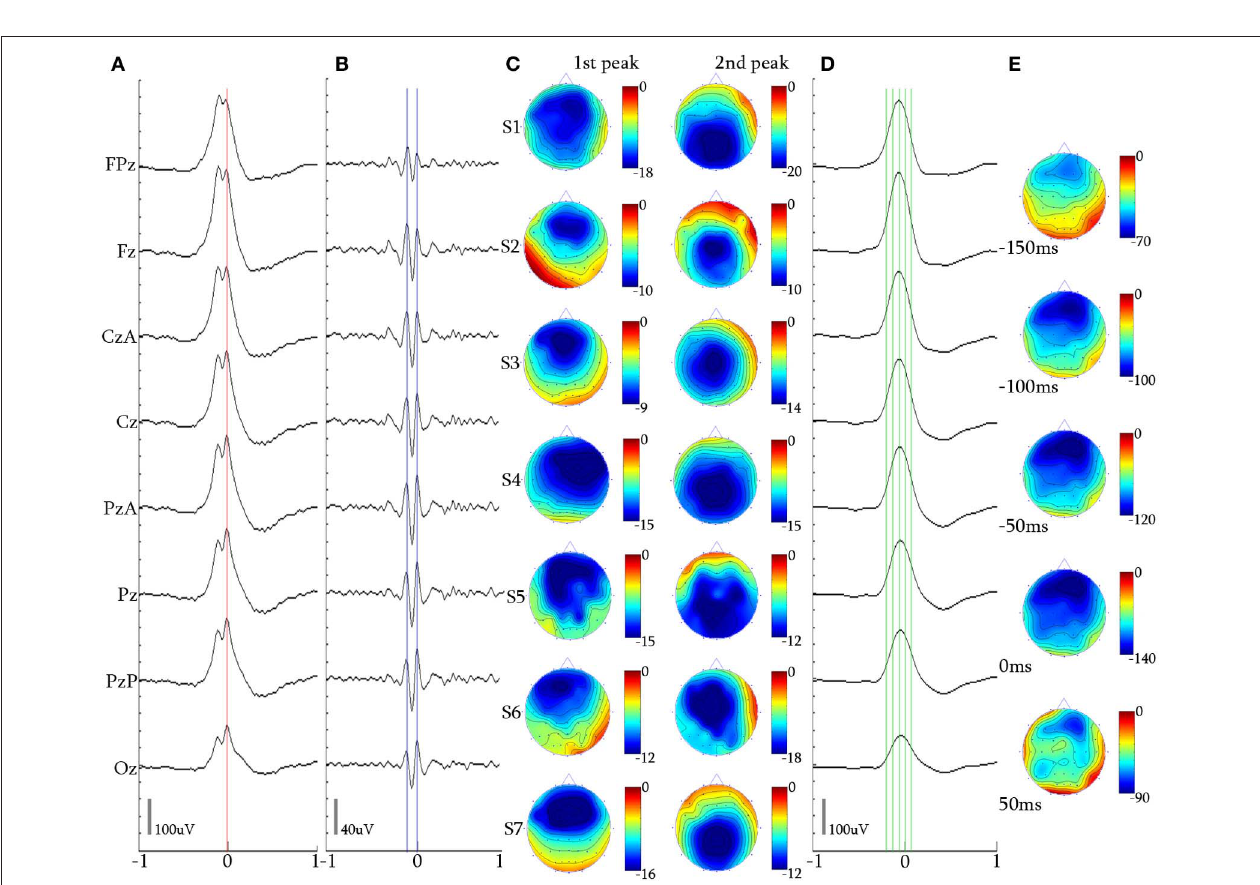
low-pass filtered waveform of the averaged KC signal of subject 1. (E) Topographic analysis in 2D electrode space of the averaged slow KC wave, representing the KCs that contained 2-peak iKCo of subject 1 at the times marked by the green cursor in (D) [Red cursor: marked reference of the 2nd peak for waveform averaging, Blue cursors: marked peaks for the topographic analysis in (C) ], Color bar units are in uV. Horizontal axis units of (A,B, and D) are in